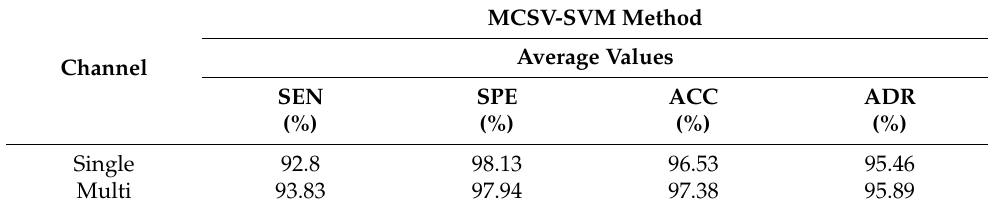
Table 2. Classification result based on MCSV-SVM using single and